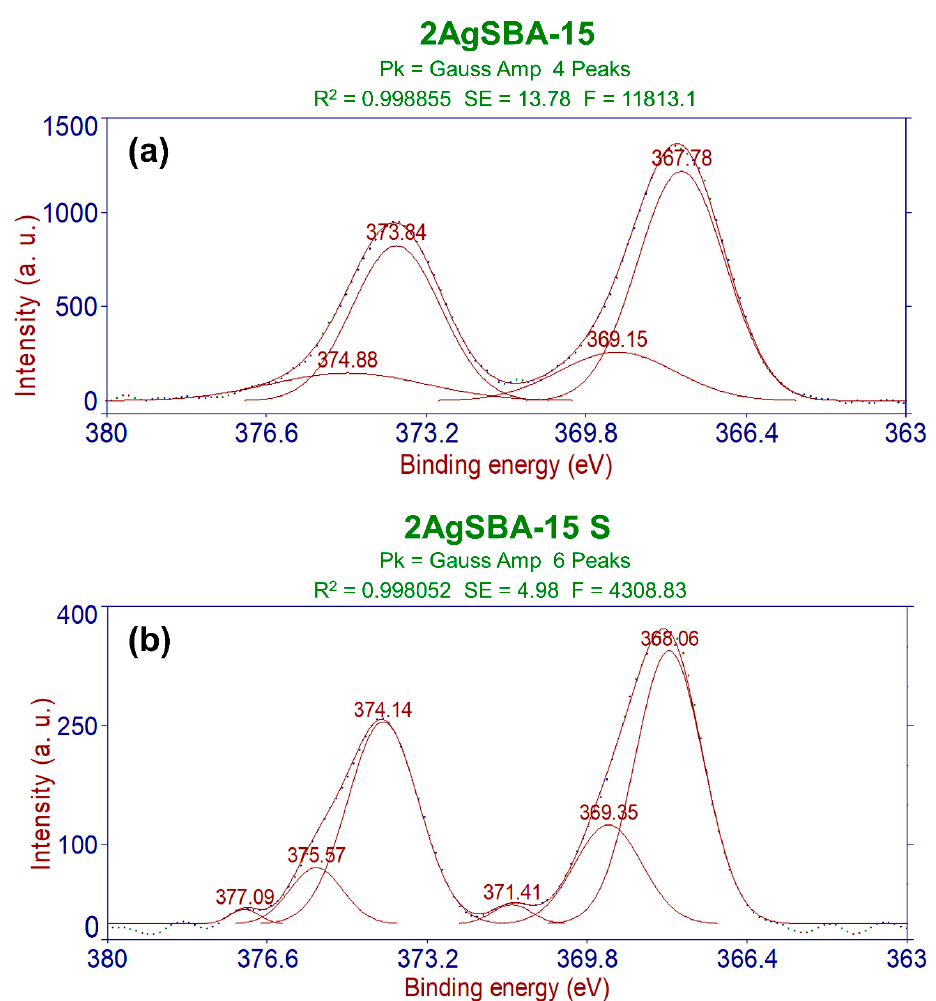
Figure 6. Deconvoluted Ag 3 d core level spectra for ( a ) 2AgSBA-15 and ( b ) 2AgSBA-15 S.